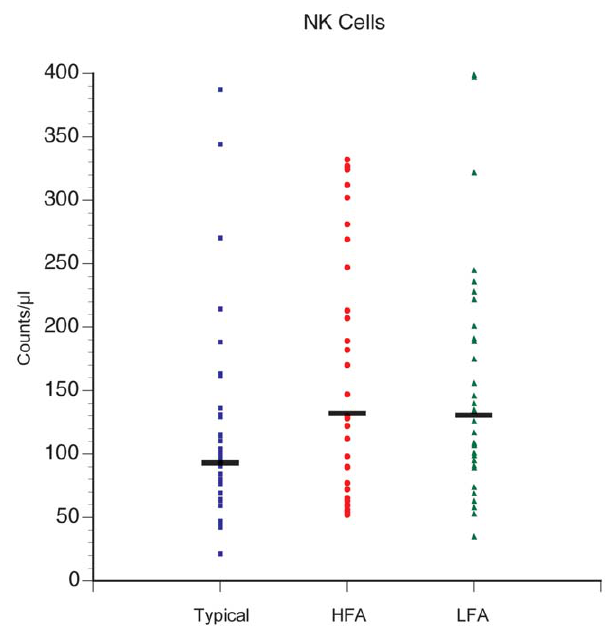
Figure 2. Average NK cell counts are higher in the HFA and LFA groups compared with typically developing controls. The average is based on 2 separate NK cell assays that use the CD56p and CD3n as the NK cell identifier. P-values=*HFA vs. N=0.037, *LFA vs. N=0.023, and A vs. N=0.011. HFA vs. LFA=not significant (0.8). doi:10.1371/journal.pone.0019299.g002 PLoS ONE |